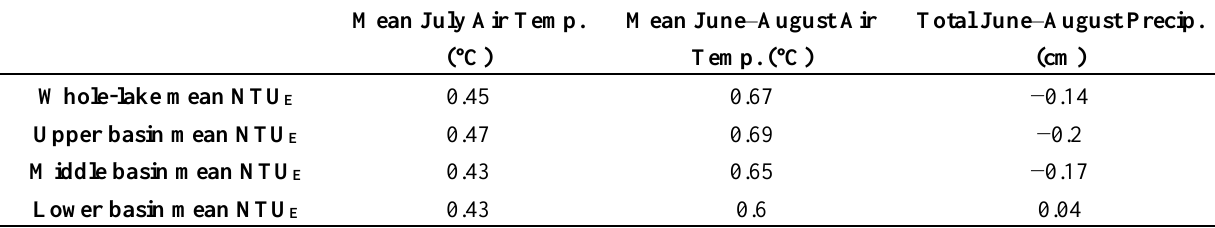
Table 3. Pearson correlation matrix between Lake Clark weather data for 1991–2014 and mean NTU E for different regions of Lake Clark when available. Only full extent scenes included (n = 53). No Landsat data available for 1992–1994, 1996–1998, and 2006. Mean July Air